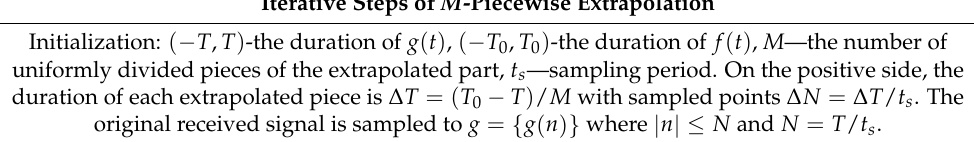
Table 1. M -piecewise extrapolation. Iterative Steps of M -Piecewise